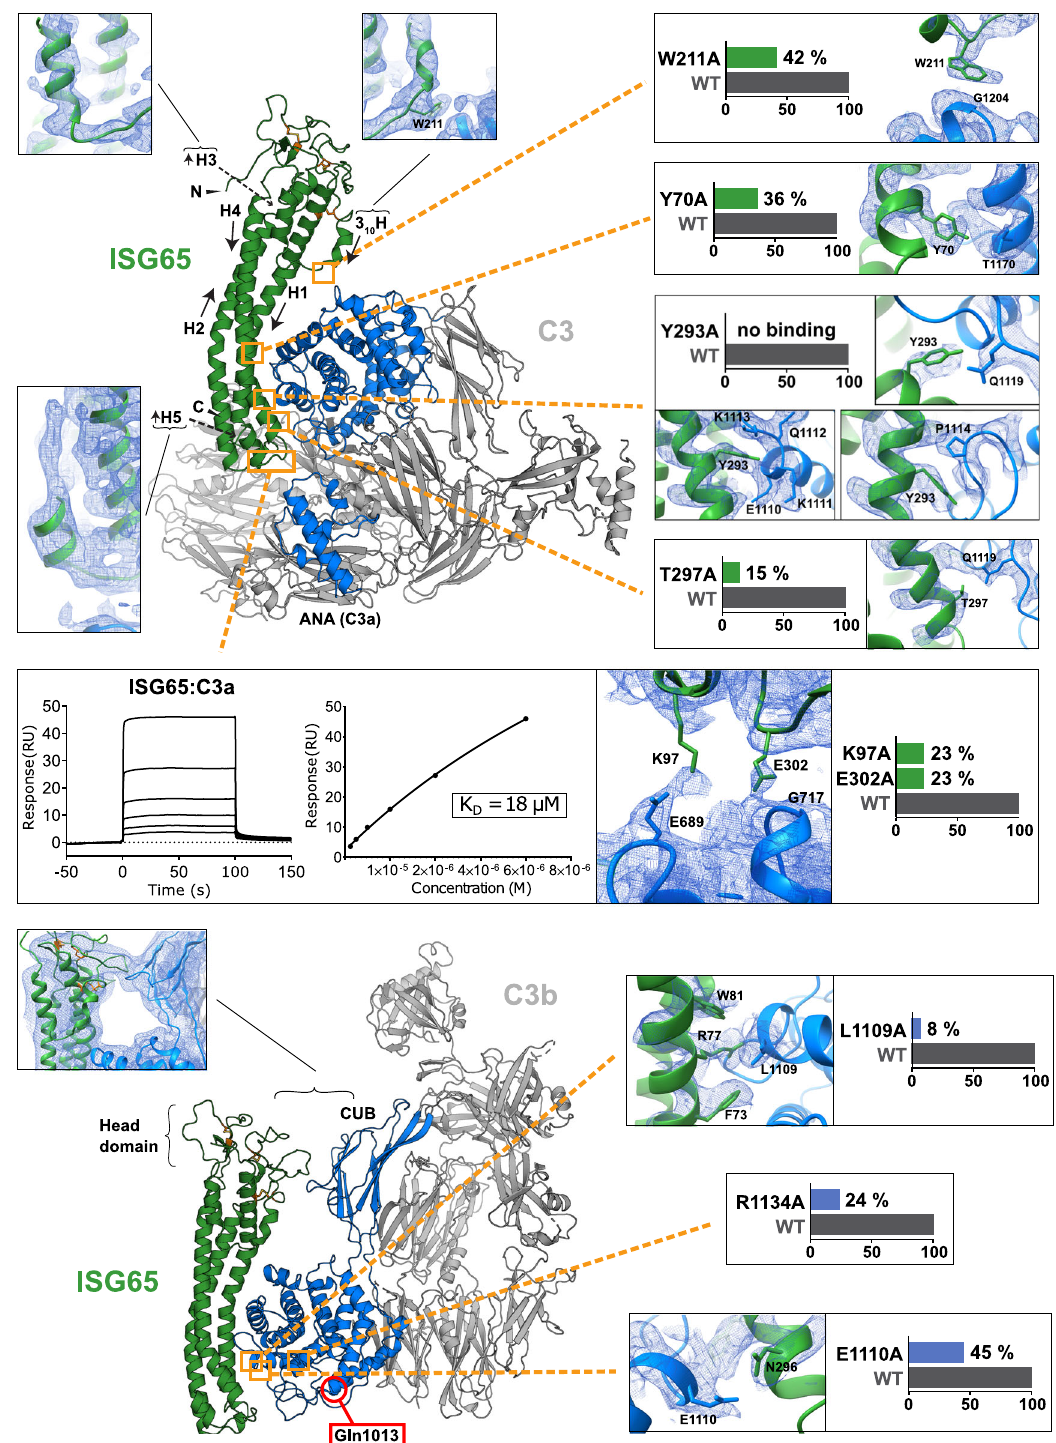
Fig. 7 | Close-up views of different regions in ISG65 and C3/C3b. Models of ISG65:C3 and ISG65:C3b are shown in cartoon representation, the directionality of helices in ISG65 is indicated by arrows. Gln1013 of the broken thioester bond is marked by a red circle. Orange rectangles indicate the positions of ISG65 and TED interface residues that were mutated. Presented bar diagrams show the relative effectsofalaninemutationsinISG65andTEDontheoverallbindingaf fi nity.Close- upsofrelevantareasandinteractingresiduesintheISG65:C3complexareshownin